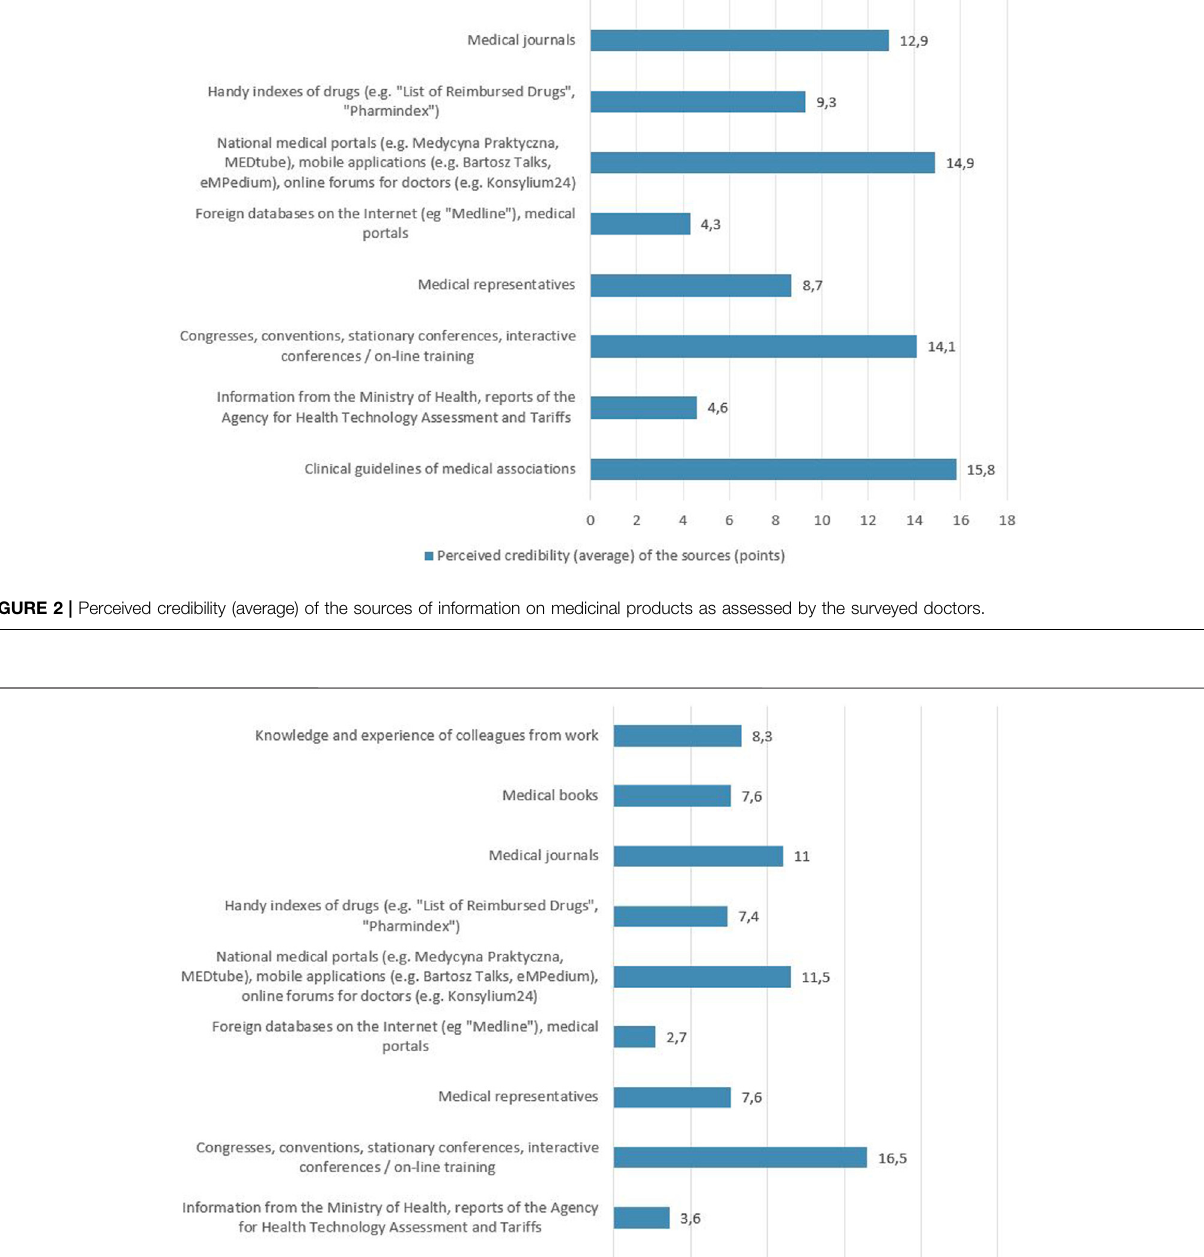
Frontiers in Pharmacology |